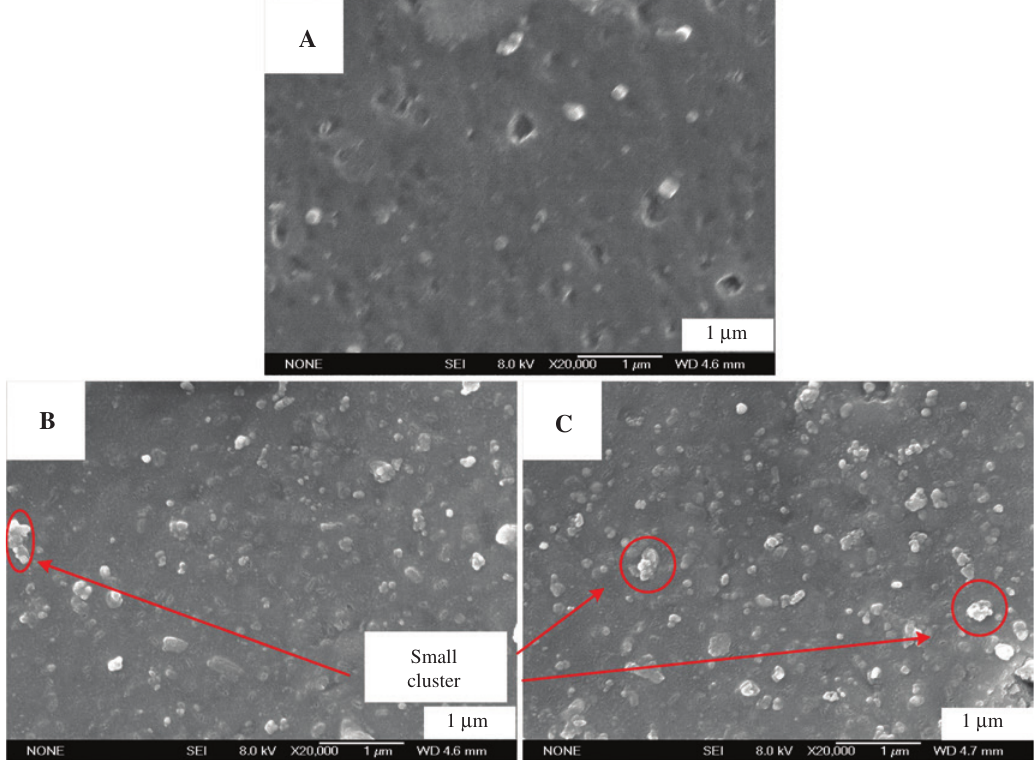
/Al2014 composites reinforced with different contents of SiC particles: (A) 0.5 p